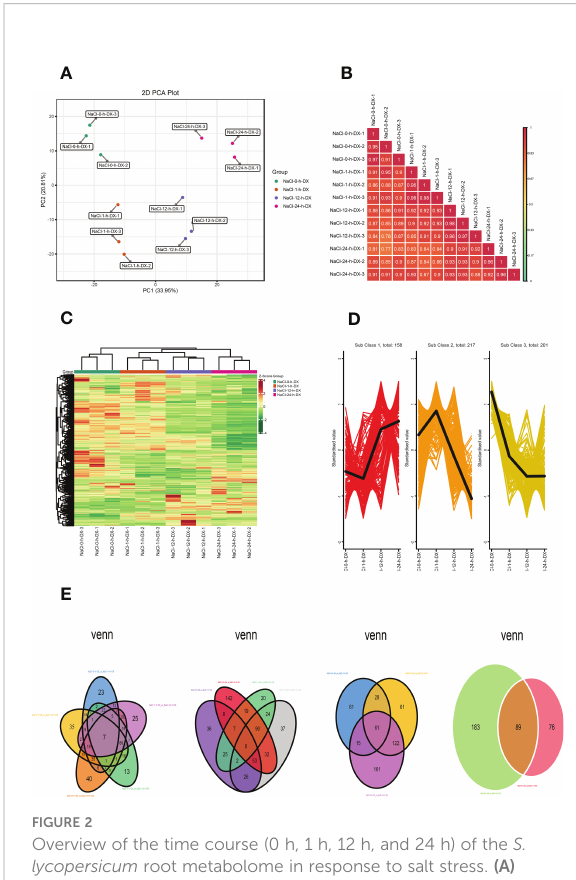
FIGURE 2 Overview of the time course (0 h, 1 h, 12 h, and 24 h) of the S. lycopersicum root metabolome in response to salt stress. (A) The plot of the overall sample PCA analysis. PC1 indicates the fi rst principal component, PC2 indicates the second principal component, and the percentage denotes the explanation rate of this principal component for the data set, each dot in the plot indicates one sample, and samples of the identical cluster are denoted using the identical color. (B) Correlation plot of inter- sample. The vertical and diagonal lines represent the sample names of various samples, and various colors indicate various |r| magnitudes, the redder the color means stronger positive correlation, the greener the color means poorer correlation, and the bluer the color means stronger negative correlation, while the correlation coef fi cient magnitudes between two samples are marked in the squares. (C) Graph of the results of cluster analysis. Horizontal is the sample description, vertical is the metabolite pro fi le, the group is the grouping, class is the substance classi fi cation, and various colors are the values derived after normalization of relative content (red means high content, green means low content). (D) The plot of K-means cluster analysis. The horizontal coordinate indicates the sample title, the vertical coordinate indicates the normalized metabolite relative content, the ‘ Sub Class ’ denotes the amount of metabolite classes with a similar trend, and ‘ total ’ denotes the total amount of metabolites in that class. (E) Venn diagram of DAMs. Each circle in the graph denotes a comparison group, and the DAMs were analyzed for fi ve, four, three, and two comparison groups in left-to-right order, respectively. The numbers in the overlapping part of circles and circles represent the number of DAMs shared between comparison groups, and the numbers without the overlapping part represent the amount of DAMs speci fi c to the comparison